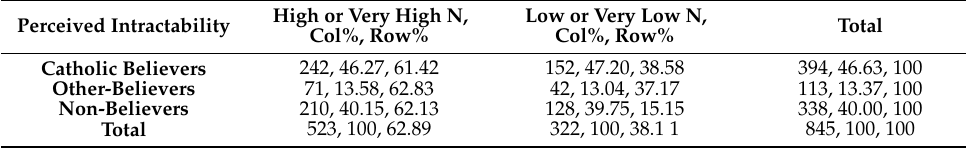
Table A8. Cross-table religious groups and perceived